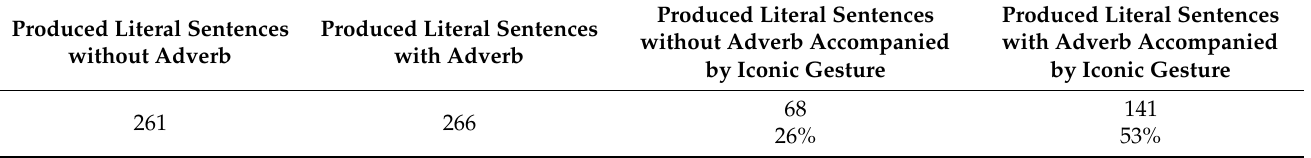
Table 1. Number and proportion of using iconic gestures with literal sentences (without or with manner